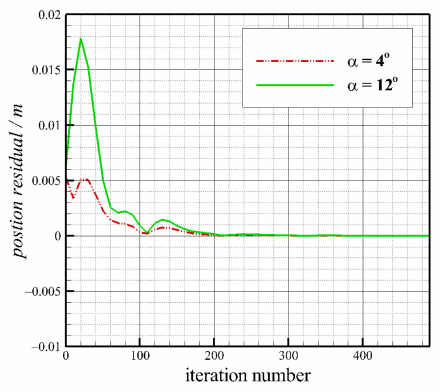
Figure 9. Convergence curve of airfoil circulation.